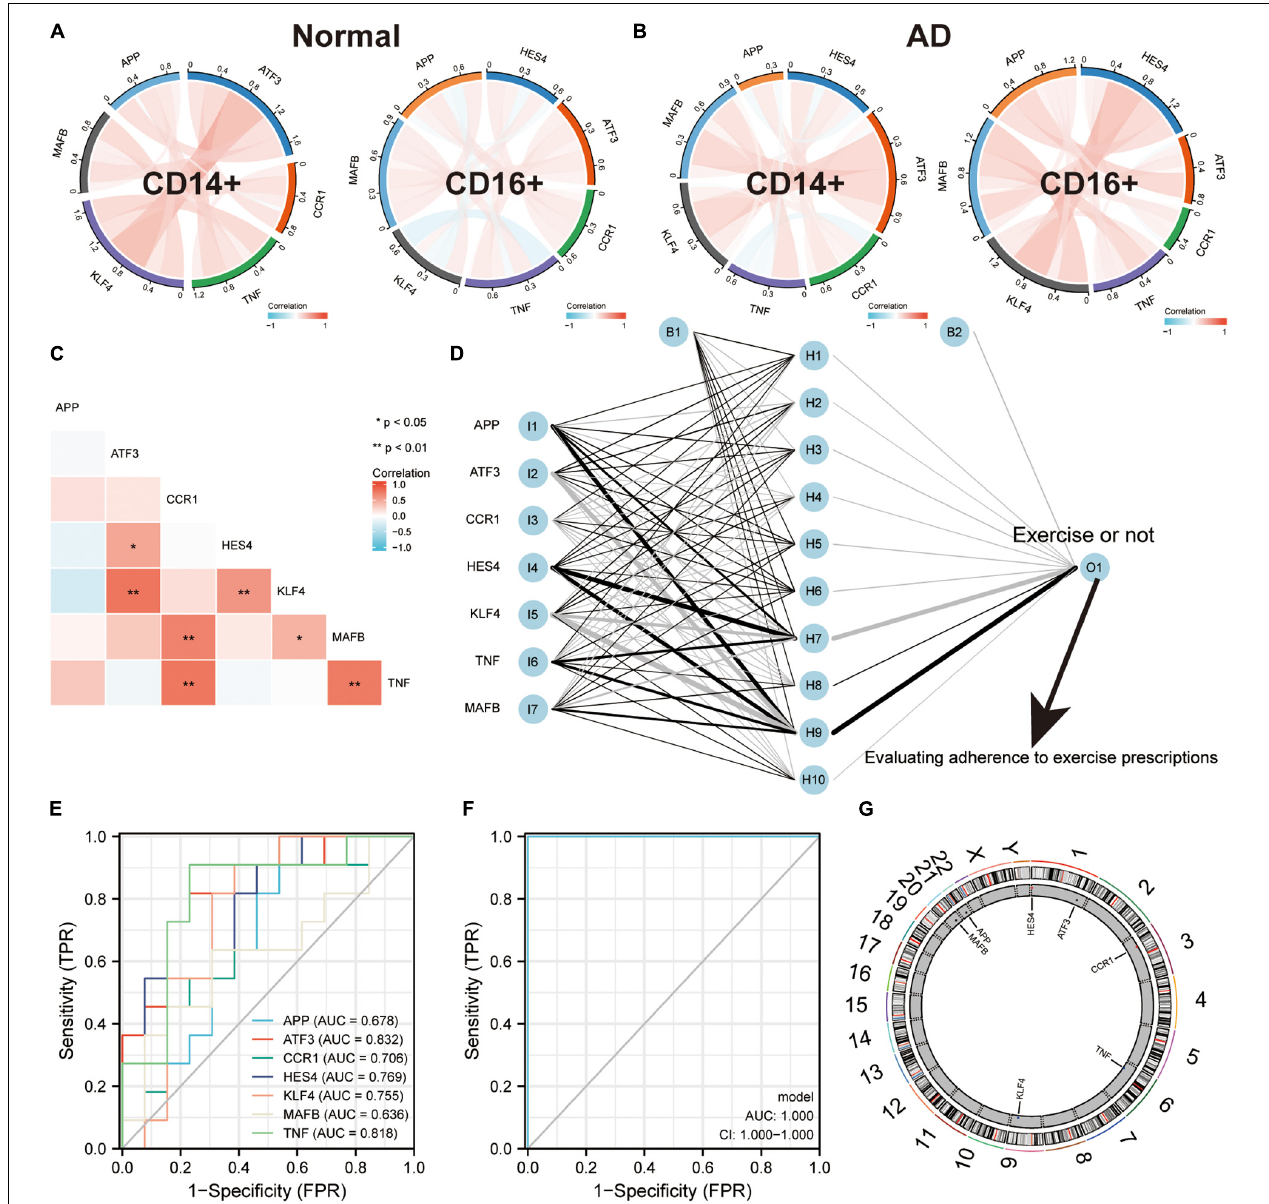
FIGURE 8 | ERADMT gene set as an indicator for assessing adherence to exercise prescription in patients with AD. (A,B) Correlation of APP , CCR1 , TNF , ATF3 , KLF4 , HES4 , and MAFB expression in CD14 + and CD16 + monocytes based on the GSE181279 single cell dataset, analyzed using Person method, including NC group (A) and AD group (B), red indicates positive correlation whereas blue indicates negative correlation; (C) Expression correlations of APP , CCR1 , TNF , ATF3 , KLF4 , HES4 , and MAFB in monocytes were analyzed using the Person method based on the GSE181279 bulk RNA dataset; (D) Schematic diagram of a neural network model for determining whether to exercise using APP , CCR1 , TNF , ATF3 , KLF4 , HES4 , and MAFB ; (E) The predictive ability of the ERADMT gene set ( APP , CCR1 , TNF , ATF3 , KLF4 , HES4 , and MAFB ) to separately predict whether to undergo exercise or not; (F) ROC curve indicating that the neural network model can accurately predict patients’ exercise compliance; (G) The position of the ERADMT gene set ( APP , CCR1 , TNF , ATF3 , KLF4 , HES4 , and MAFB ) on the chromosome is indicated by the circle